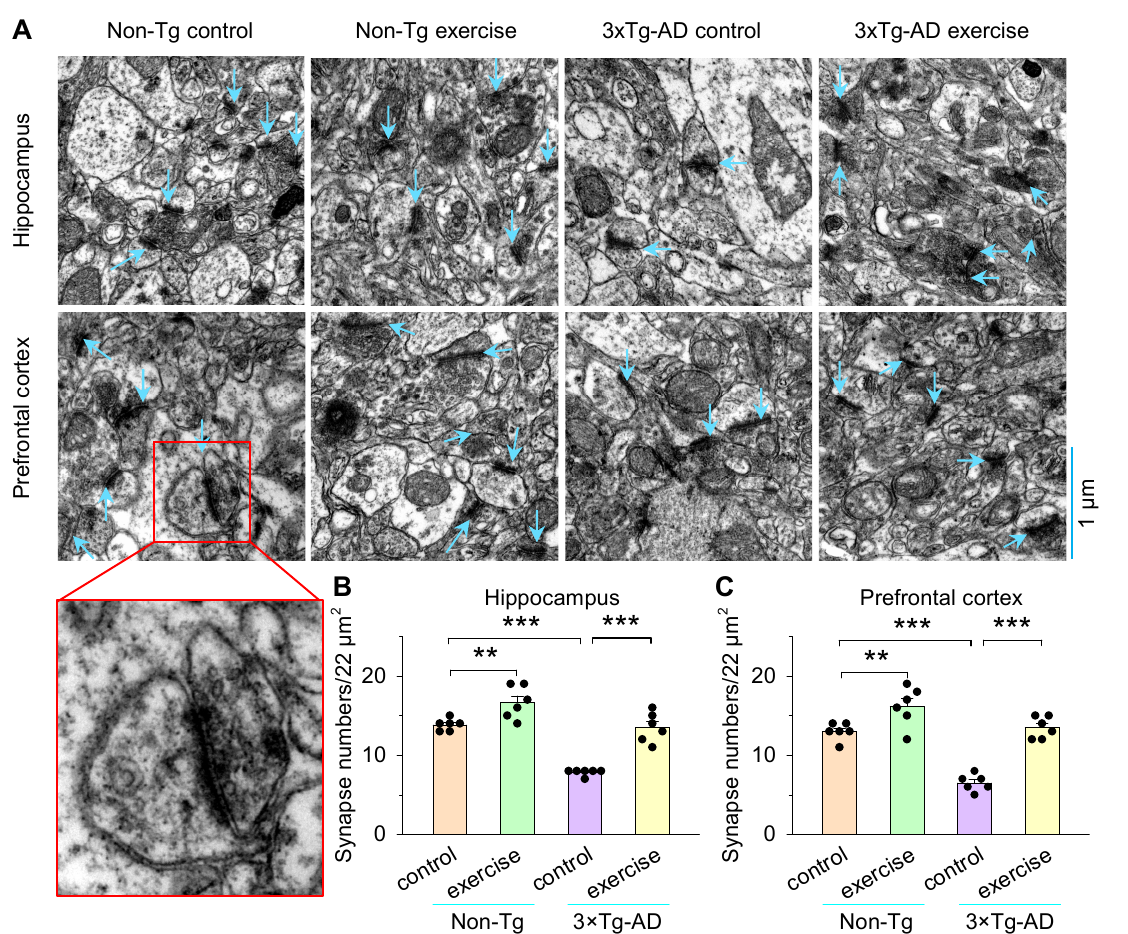
Figure 2. Treadmill exercise increases synapse numbers of hippocampus and prefrontal cortex in 3 × Tg-AD mice. ( A ) Representative electron microscope imaging of hippocampus and prefrontal cortex in non-Tg control, non-Tg exercise, 3 × Tg-AD control, and 3 × Tg-AD exercise mice. The synapses are marked by the blue arrowheads. Red box represents an enlarged synapse. An expanded, high magnification view of synapses in the prefrontal cortex is shown in the red square box in the bottom. ( B , C ) The synapse numbers of hippocampus ( B ) and prefrontal cortex ( C ) were significantly decreased in the 3 × Tg-AD control group compared to the non-Tg control group (*** p < 0.001, n = 6 image sections), and this decrease was blocked by treadmill exercise pretreatment both in the hippocampus ( B ) and prefrontal cortex ( C ) (*** p < 0.001, n = 6 image sections). Treadmill exercise pretreatment increased the synapse numbers of the hippocampus ( B ) and prefrontal cortex ( C ) in non-Tg mice (** p < 0.01, n = 6 image sections). Each data set was obtained from 4